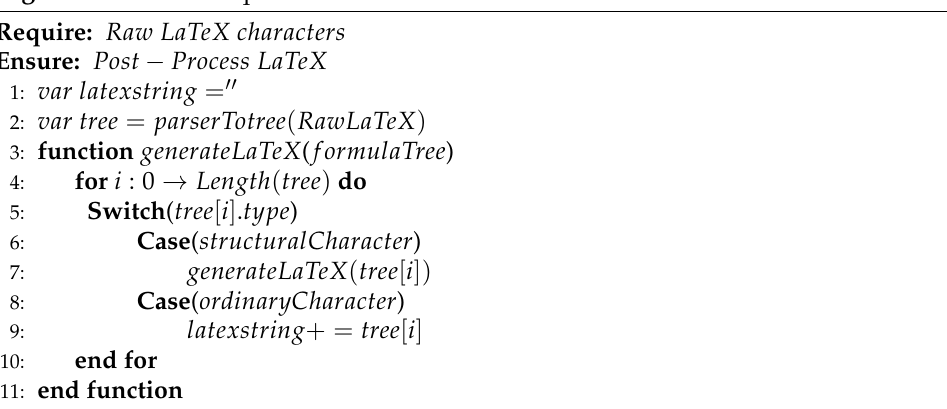
Algorithm 1 LaTeX sequence